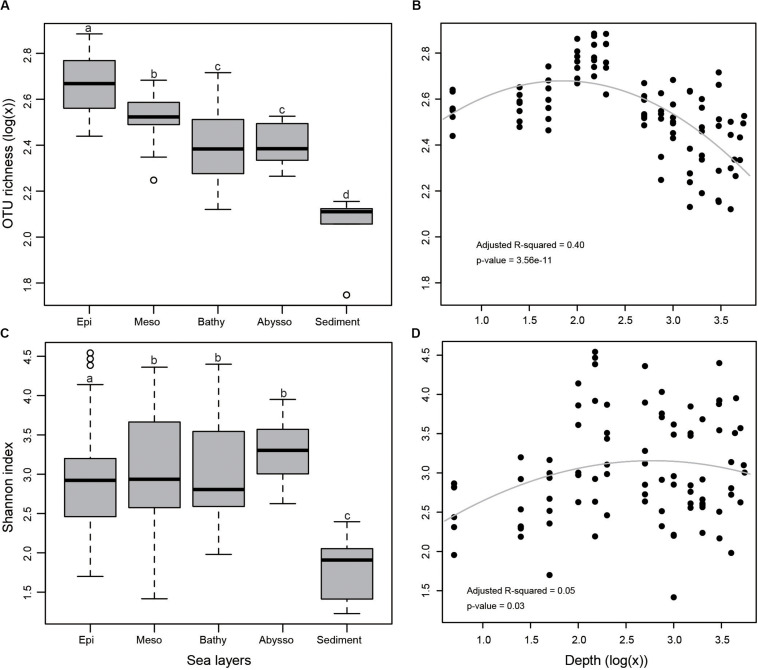
(A) Bacterial OTU richness in different zones as demonstrated by a boxplot with median and 95% confidence intervals, (B) multiple regression of OTU richness with depth, (C) Shannon index, and (D) multiple regression of Shannon index with depth. Bars without shared letters indicate significant differences at the level of adjusted p-value <0.05.